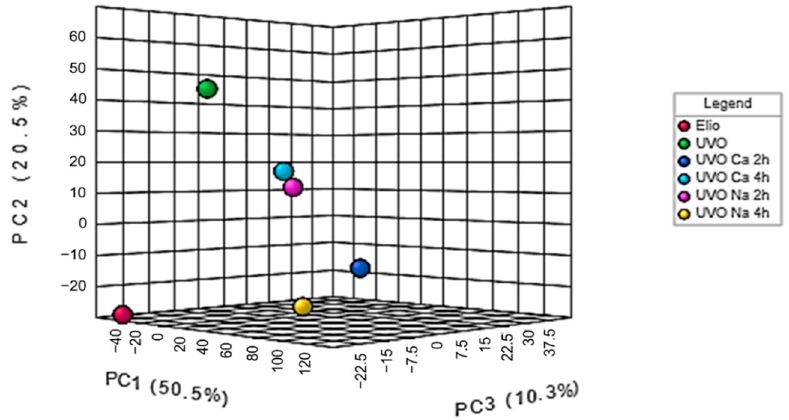
Figure 2. 3D PCA plot of edible, waste, and treated oil samples.